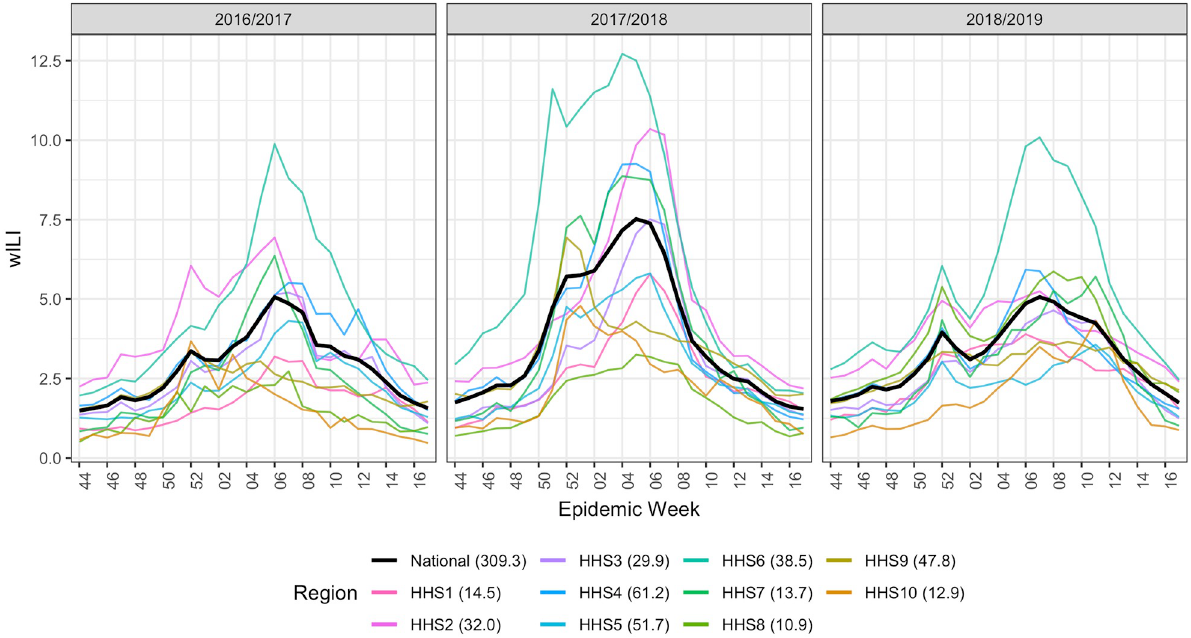
Fig 1. Data example for the three test seasons under consideration (2016/2017, 2017/2018, 2018/2019) season for all 10 Health and Human Services (HHS) regions and the national level. At any given epiweek, the national wILI (black) is a weighted sum of regional wILI, where the weights correspond to the population size of the region. We can see that wILI is highly seasonal and varies heavily by region. Region population sizes (in millions) are given next to the region in the legend.